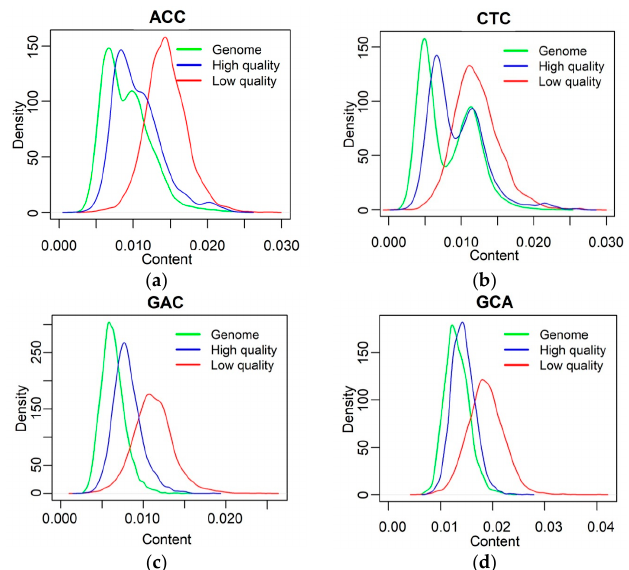
Figure 2. Distribution of nucleotide combinations of genome, high-quality, and low-quality reads of four example trinucleotides: ( a ) ACC; ( b ) CTC; ( c ) GAC; ( d ) GCA. The green, blue, and red lines represent the data from genome (gold-standard error-free reads), high-quality (corrected reads), and low-quality reads (raw reads), respectively. Table 1. Summary of the results of Escherichia coli in selection, correction, and contigs. REQUEST—Read Quality Evaluation and Selection